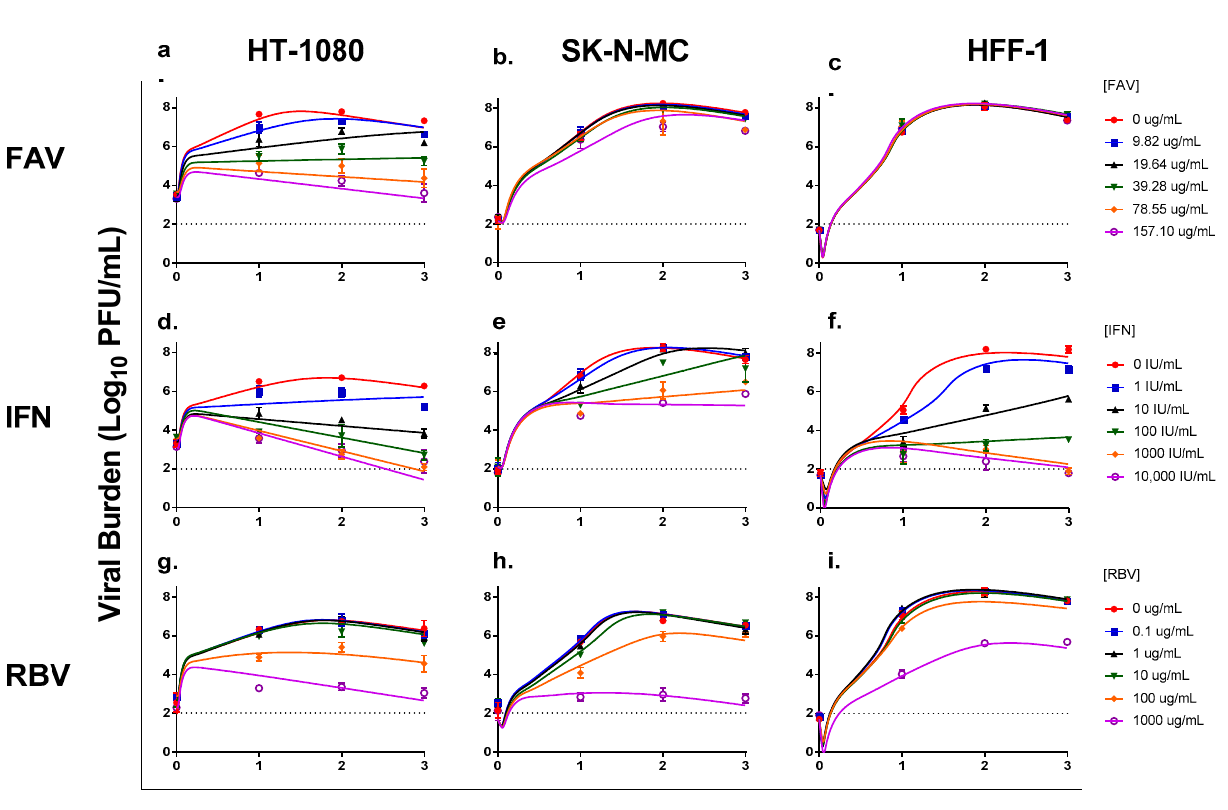
Figure 1. Antiviral activity of favipiravir (FAV), interferon-alpha (IFN), and ribavirin (RBV) monotherapy against Chikungunya virus (CHIKV) in human connective tissue (HT-1080), neurons (SK-N-MC), and skin (HFF-1) cells. HT-1080 ( a , d , g ), SK-N-MC ( b , e , h ), and HFF-1 ( c , f , i ) cells were infected at multiplicities of infection of 0.1, 0.01, and 0.001, respectively. Infected cells were treated with different concentrations of FAV, IFN, or RBV. Viral burden was quantified via plaque assay on Vero cells, and reported as log 10 plaque-forming units/mL (PFU/mL). Data points represent the mean of three independent observations and error bars correspond to one standard deviation (for some observations, the error bars were smaller than the markers). The lines through the data points signify the individually fitted viral burden as determined by the mathematical model. The dashed line signifies the assay limit of detection.